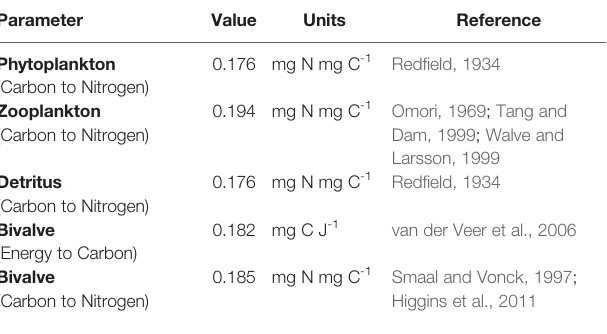
TABLE 1 | Conversion coef fi cients used to express the different model variables in a common nitrogen currency.